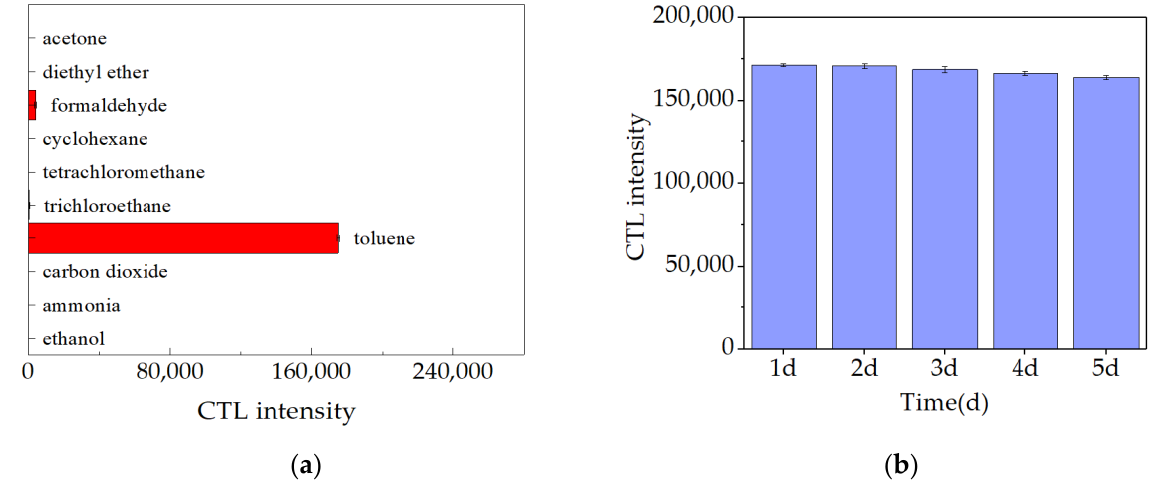
Figure 6. ( a ) Selectivity of the Pt/Ti 3 C 2 T x -CNT for toluene; ( b ) stability of the Pt/Ti 3 C 2 T x -CNT for toluene (detecting concentration: 87 ppm; working temperature: 150 °C; airflow rate: 200 mL/min).